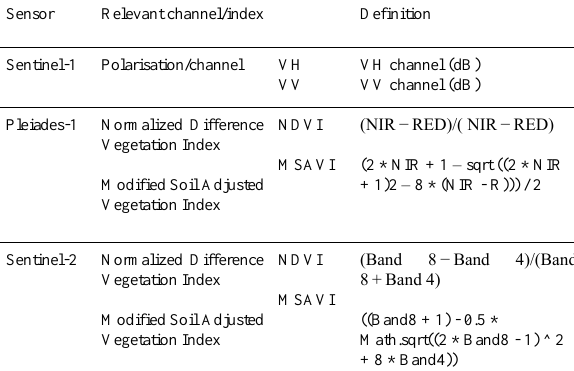
Table 2. Remote sensing data description and vegetation